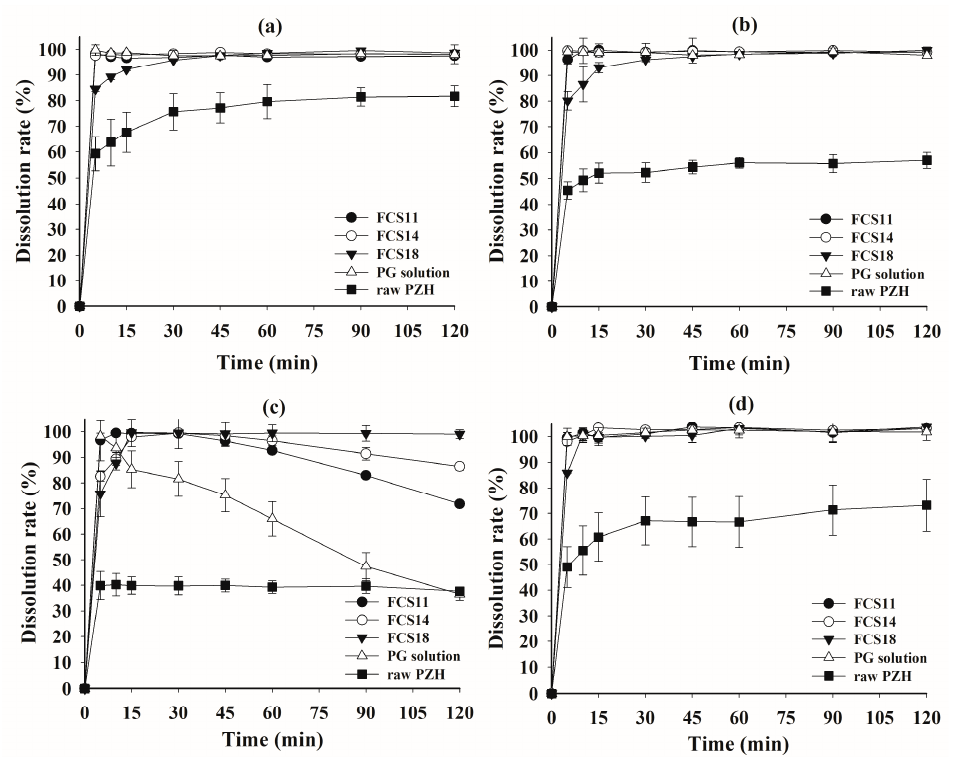
Figure 5. Dissolution profiles of FCS formulations and raw PZH in pH 1.2 buffer ( a ), pH 4.0 buffer ( b ), pH 6.8 buffer ( c ), and water ( d ) with 1% polysorbate 80.